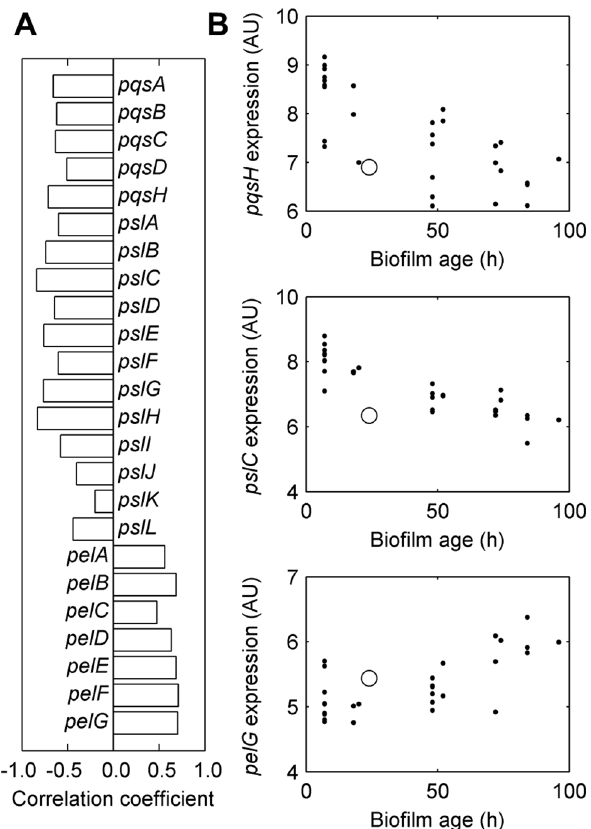
Fig 2. Expression of pqs , psl , and pel operons as a function of biofilm age. (A) Correlation coefficient of the expression intensity of the genes in the pqs , psl , and pel operons and biofilm age (h). (B) Expression of one gene from each operon as a function of biofilm age. Gene expressions are shown in log 2 scale. Each dot corresponds to one condition in the dataset of gene expression for P . aeruginosa PAO1 biofilms. The circles correspond to the data obtained by Costaglioli et al. [11]. AU, arbitrary units; h, hours.